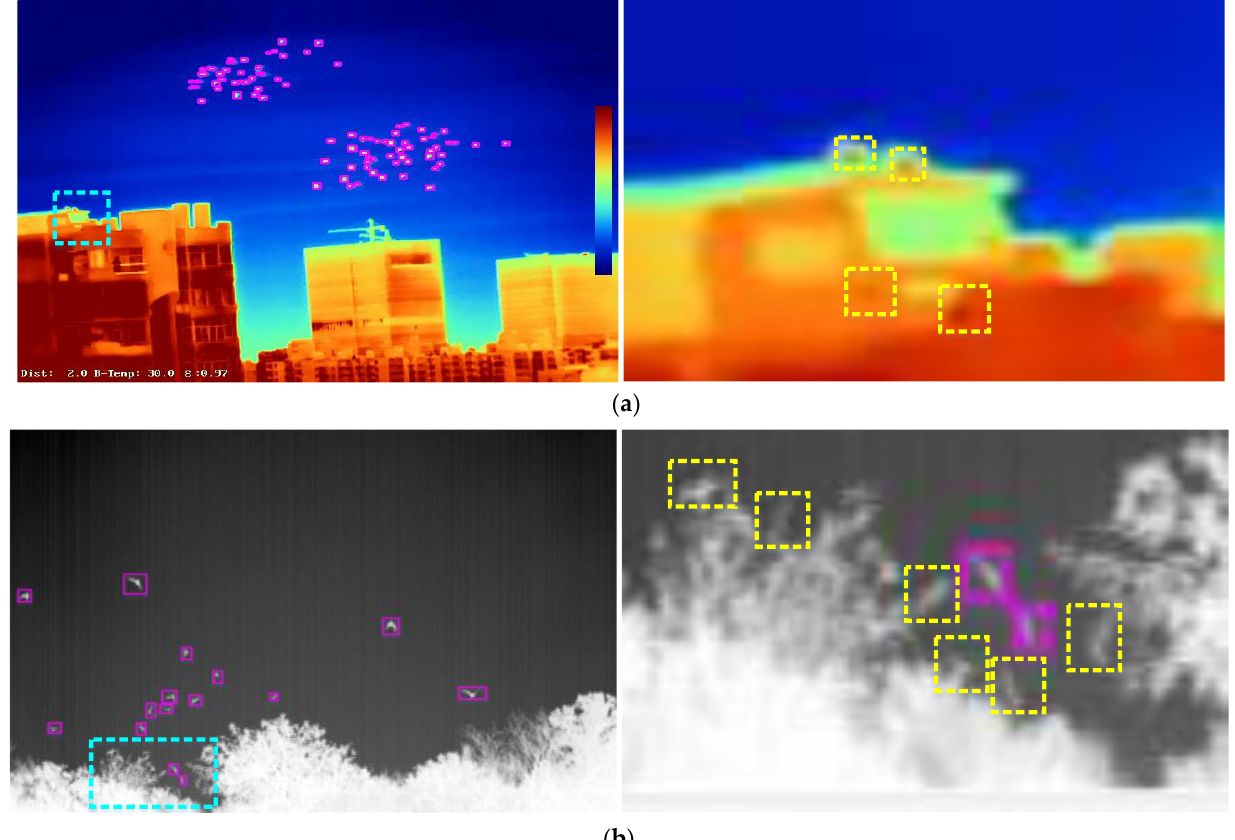
Figure 10. The target detection results in a complex background, ( a ) on our dataset, ( b ) on TIV dataset.